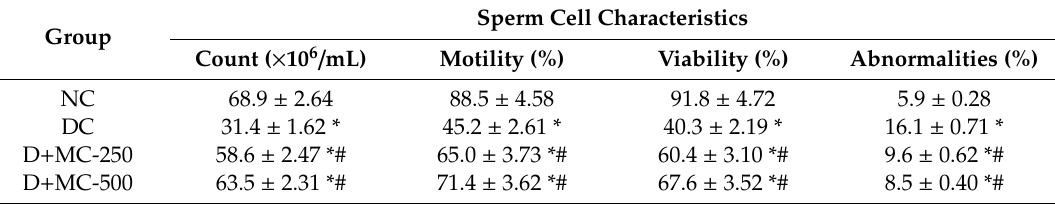
Table 4. E ff ect of MC on sperm cell characteristics of STZ-induced diabetic male rats.